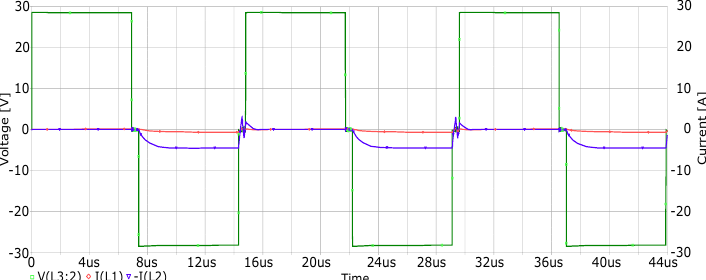
Figure 6. Simulation results of two cells, primary voltage (green), primary current (red) and secondary current